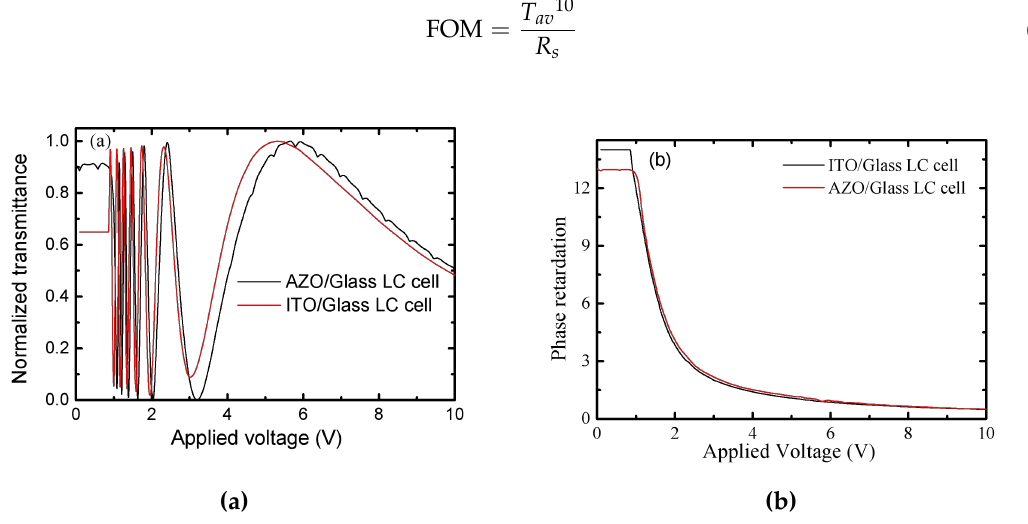
Figure 6. (a) Transmittance–voltage characteristics of AZO/glass and ITO/glass (reference) LC cells and (b) Figure 6. ( a ) Transmittance–voltage characteristics of AZO / glass and ITO / glass (reference) LC cells and phaseretardation for bothLC cells. ( b ) phase retardation for both LC cells.